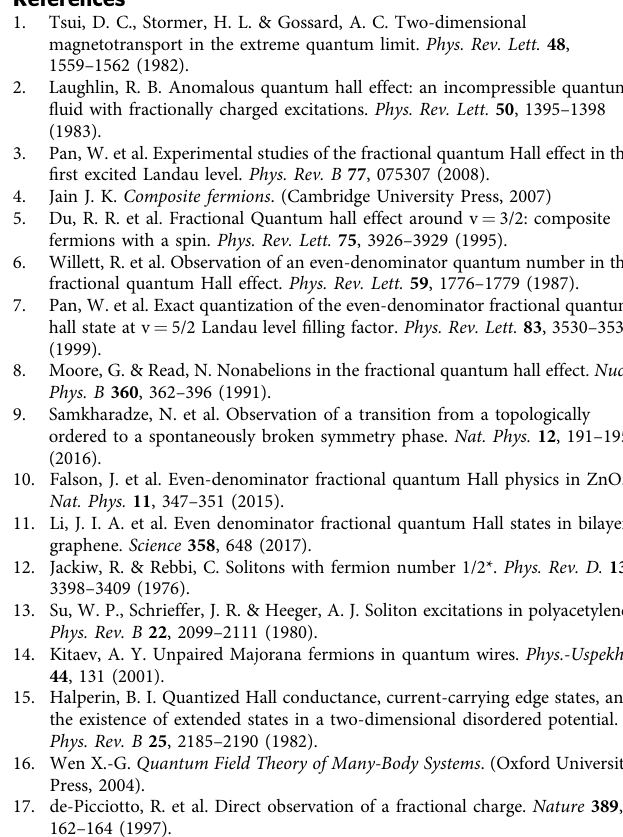
induced only by the density variation in the con fi ned region.